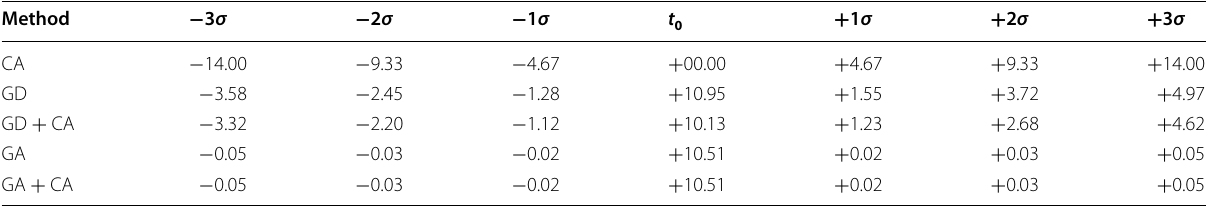
) and confidence interval limits from all methods 0